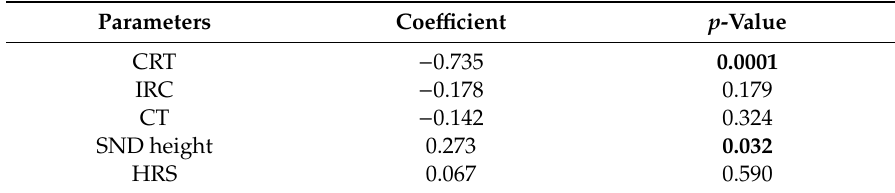
Table 5. Multiple Regression analysis for baseline OCT biomarkers predicting factors associated with improvement of baseline visual acuity > 10 ETDRS letters at end of treatment.